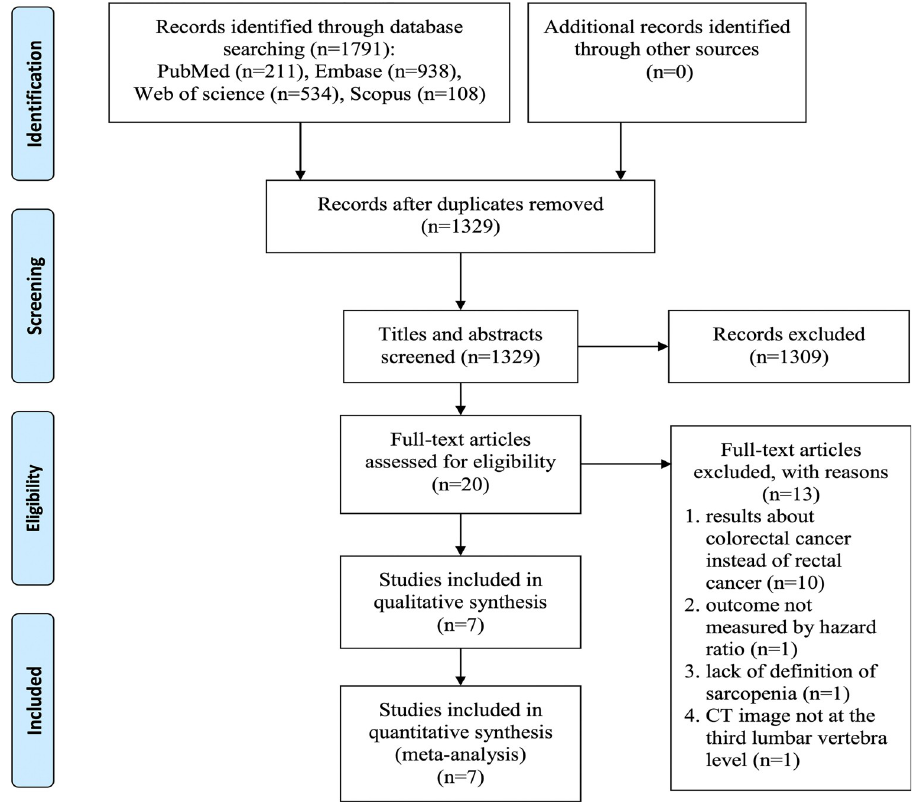
Fig 1. Flow chart of the selection process for included